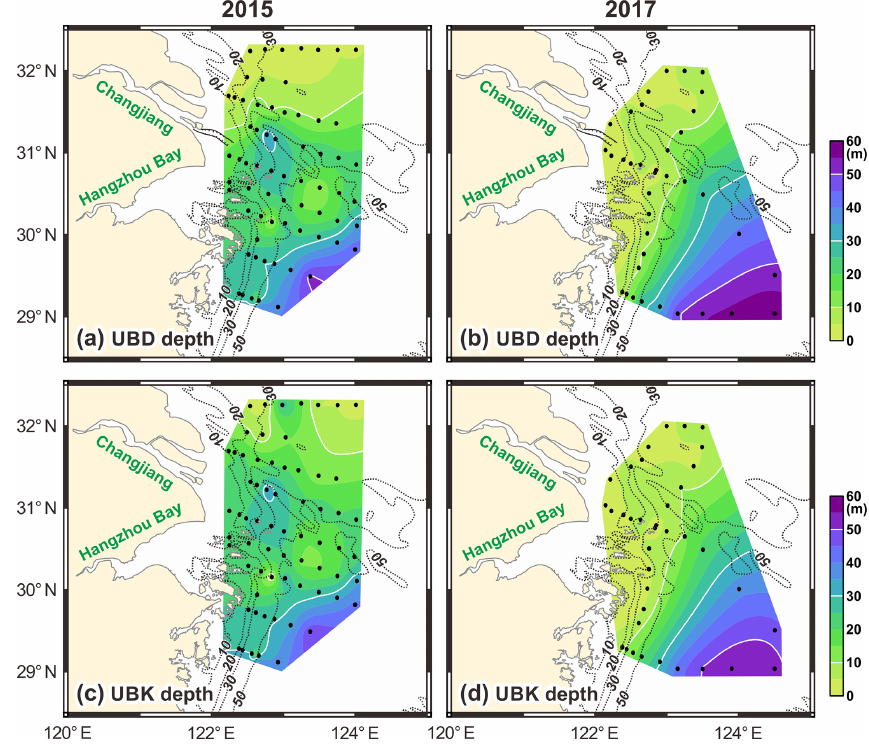
Figure 7. Maps of AOU isoline 2mgL − 1 (upper boundary of the DO depletion) depth (a, b) and temperature isoline 24.5 ◦ C (upper boundary of KSSW) depth (c, d) in 2015 (a, c) and in 2017 (b, d)